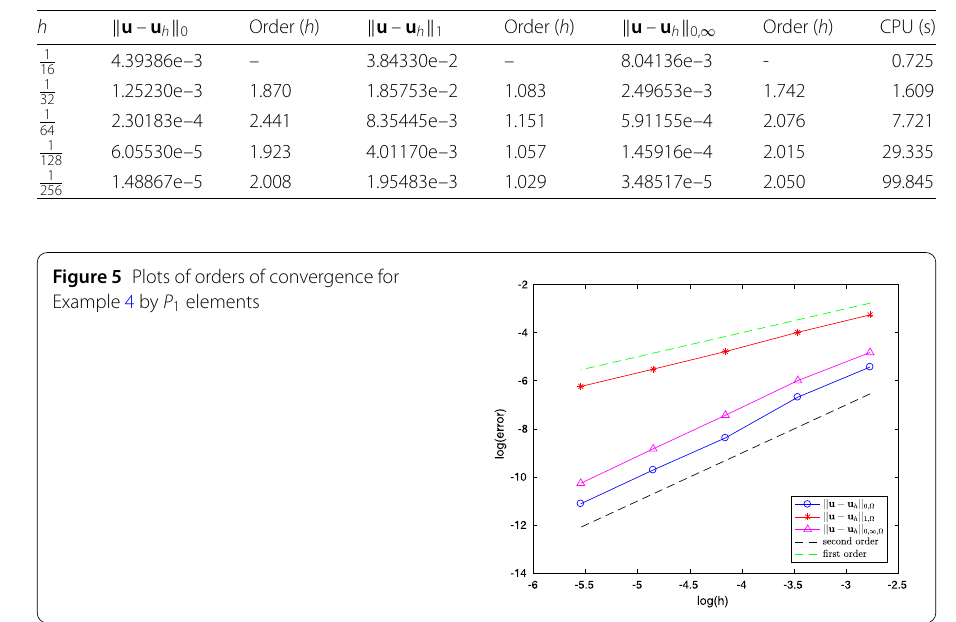
Table 4 Convergence order with respect to h of the stabilized method for Example 4 with coefficient